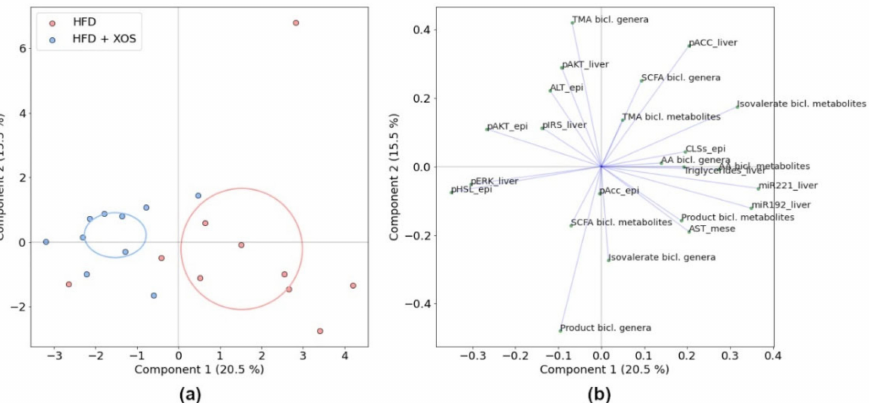
Figure 8. PCA of the HFD and HFD + XOS groups using total feature abundances in each bicluster and selected biomarkers, ( a ) Ordination and ( b ) Loading plots. The total explained variance for each component is shown in parentheses, and the ellipses indicate 95% confidence